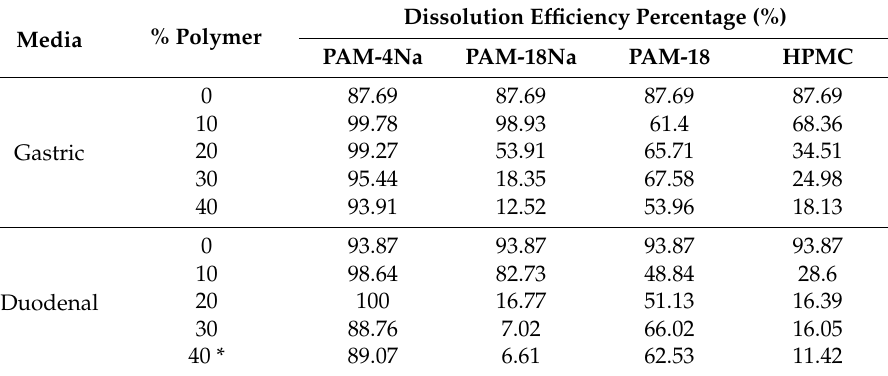
Table 6. Values of dissolution efficiency ( DE ) for ampicillin trihydrate tablets at different proportions of polymeric materials at 37 ◦ C, using two media for physiological